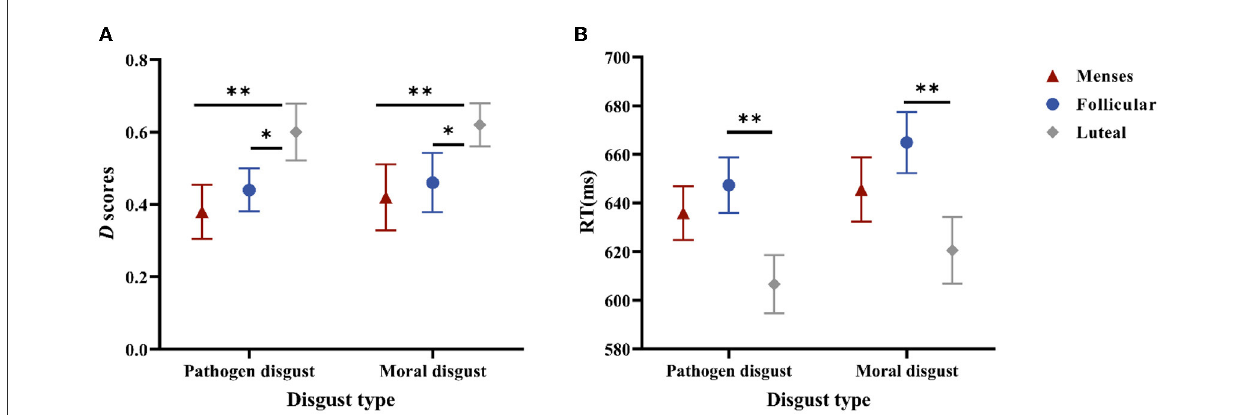
FIGURE2 Performances in the SC-IAT. (A) is the D scores for women as a function of disgust type * cycle phase. (B) is the mean RTs of the incongruent and congruent responses for women as a function of disgust type * cycle phase. Error bars represent the standard error of the mean. ** p < 0.01; * p < 0.05.